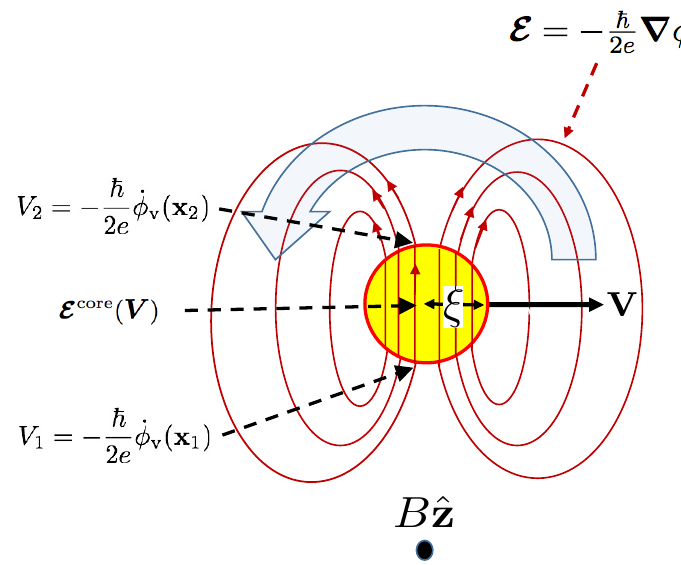
Figure 2: Electromotive force field (EMF) single moving vortex of velocity V . The circulating supercurrent is depicted by a wide blue arrow. A core EMF, the metallic region (yellow disk) of radius ξ